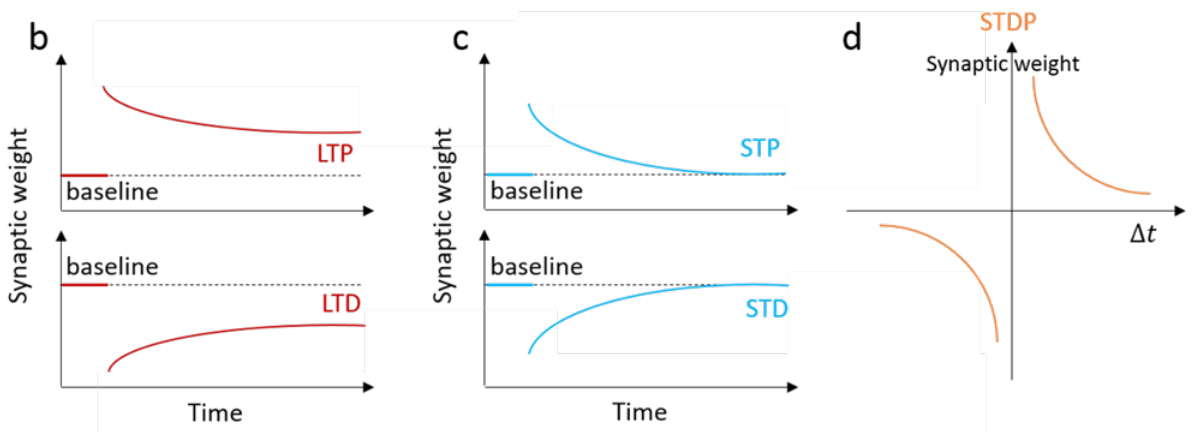
Figure 1. Properties of a biological synapse. ( a ) Schematic image of the biological synapse structure. Typical synaptic weight changes in the cases of ( b ) LTP and LTD, ( c ) STP and STD, and ( d ) STDP.